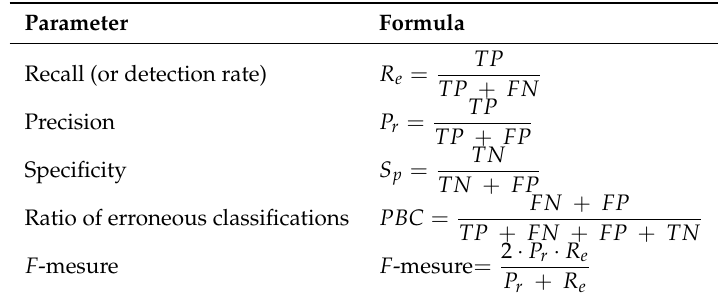
Table 2. Performance